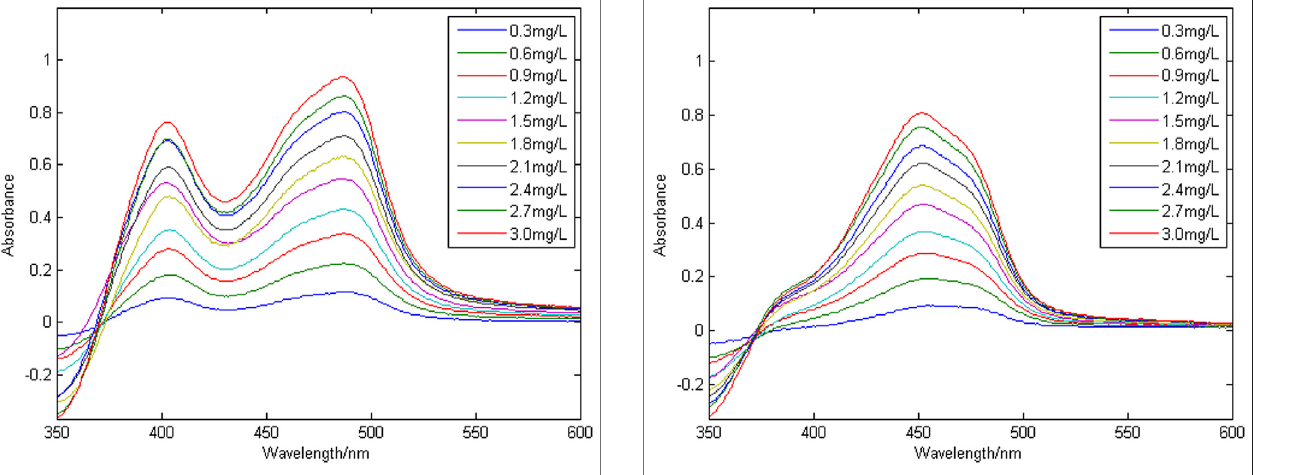
FIGURE 3 | A group of absorption spectral signals of copper. FIGURE 4 | A group of absorption spectral signals of